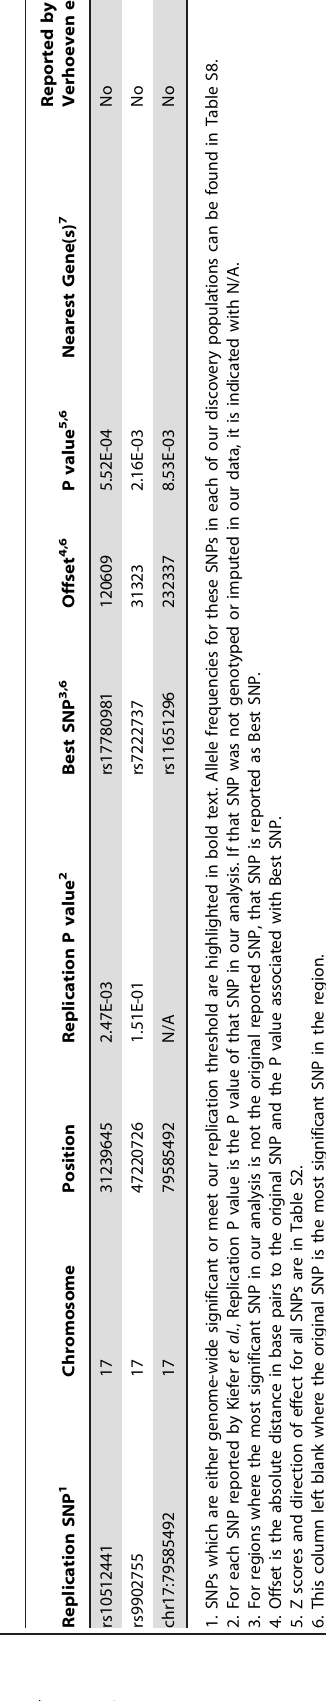
Results of the discovery meta-analysis (Figure 1, Table S4) shows one genome-wide significant marker corresponding to a previously identified myopia age at onset [18] and refractive error [19] locus on 8q12 (rs10113215, p = 1.25 6 10 2 8 ). We also observed association to the well-replicated locus on 15q14 (near GJD2 ) that was close to genome-wide significant (rs1370156, p = 2.29 6 10 2 7 ). No attempt was made to replicate the chromo- some 15q14 region since it has been well replicated. SNPs in the 8q12 replication region did not reach the replication threshold (for rs10113215, replication p =0.02; top replication p-value in the